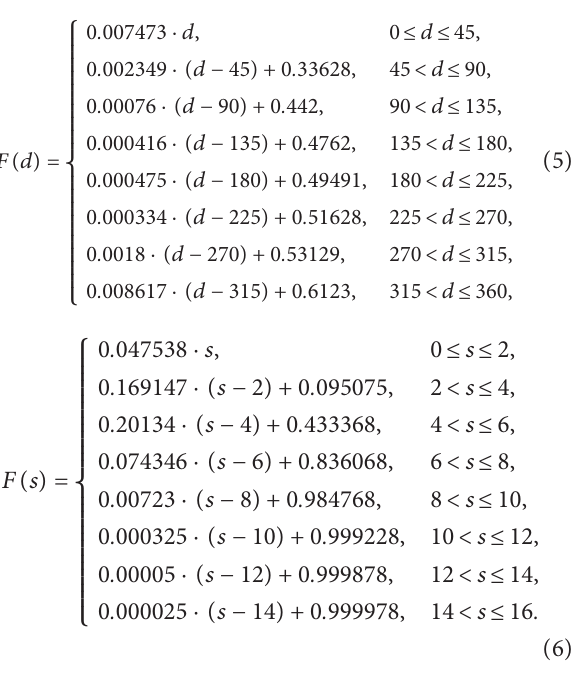
Figure 12: (a) Leak frequency of leak location variable; (b) CDF of leak location corresponding graphical expressions are shown in Fig- ures 16 and 17: